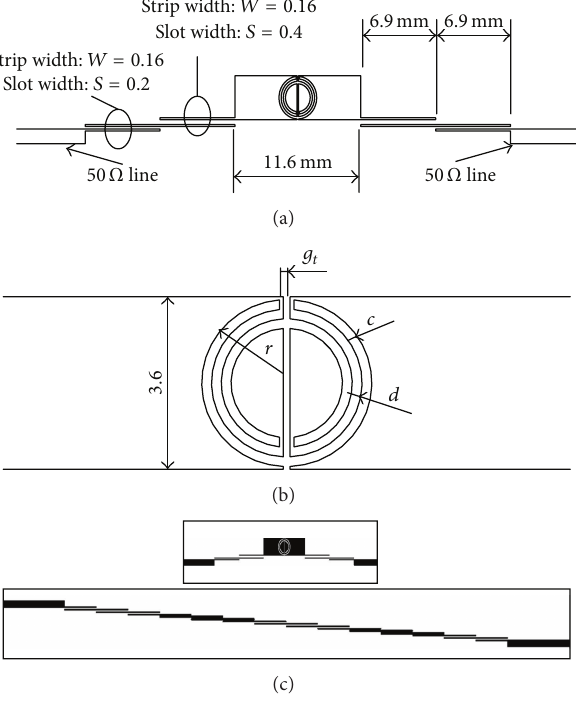
Figure 2: (a) Schematic of the compact UWB microstrip bandpass filter proposed. (b) Detail of the Modified Complementary Split Ring Resonator section. (c) Comparison between proposed filter and 14th-order Butterworth filter size with similar